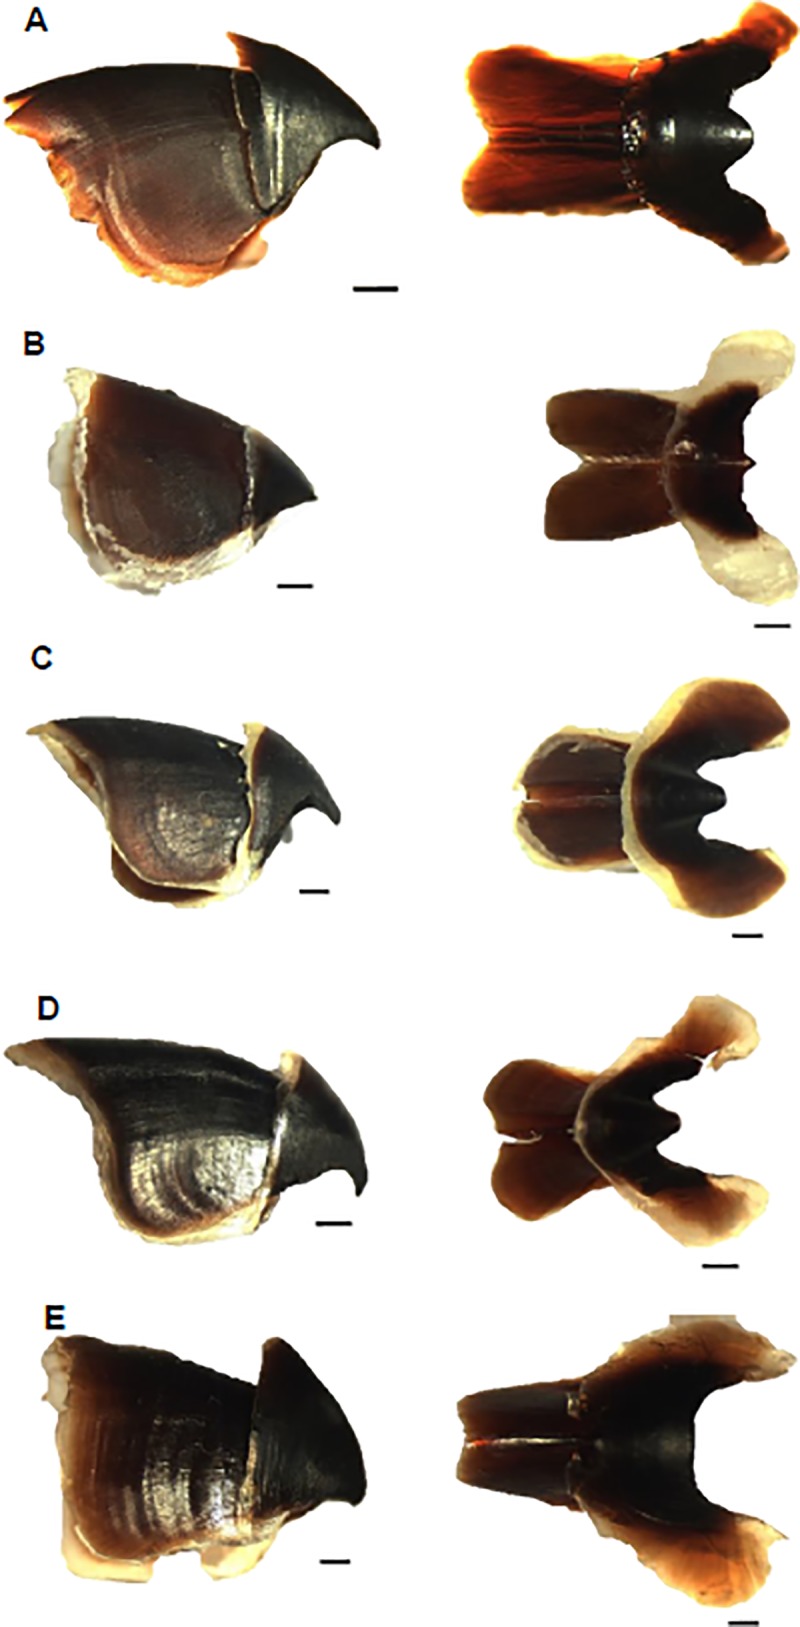
Upper (left) and lower (right) beaks of the five most abundant species of Antarctic octopods analyzed in this study. A—Muusoctopus rigbyae; B—Adelieledone polymorpha; C—Pareledone aequipapillae; D—Pareledone charcoti; E–Megaleledone setebos. Scale bars represent 1 mm.